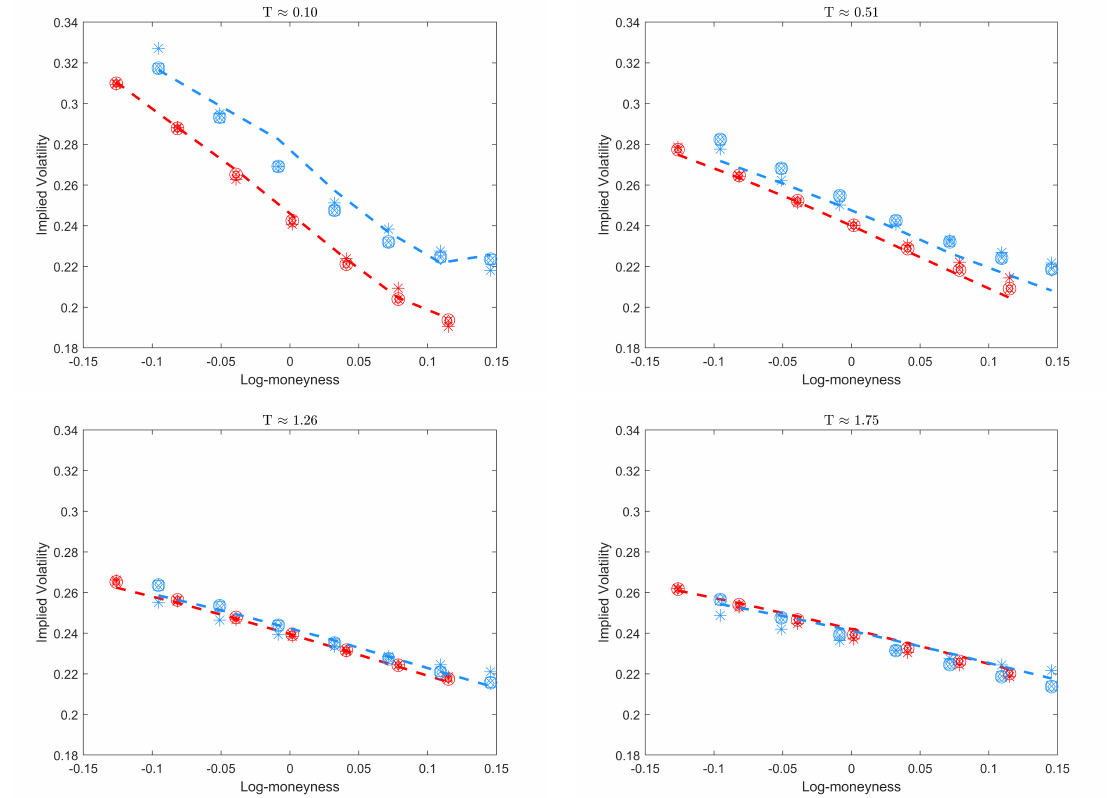
Figure 2. Implied volatility surface calibration on the SPX implied volatility (12 and 15 September 2008—dotted red and blue line) for the OGPadé (diamond marker), OFPadé approximants ( 5,4 ) , ( 6,3 ) , ( 7,2 ) (square, cross, circle marker), and approximation formula (asterisk